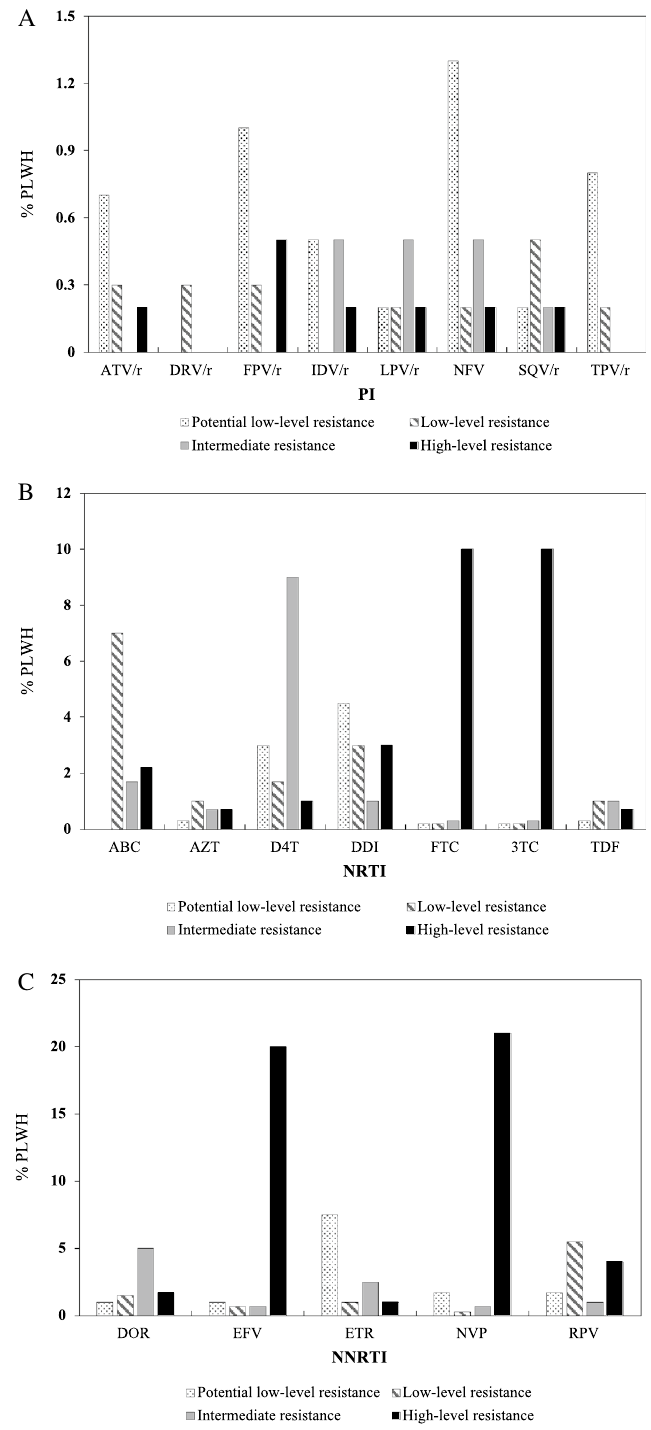
Figure 1. Antiretroviral drug resistance: ( A ) PI. r ritonavir-boosted, ATV atazanavir, DRV darunavir, FPV fosamprenavir, IDV indinavir, LPV lopinavir, NFV nelfinavir, SQV saquinavir, TPV tipranavir. ( B ) NRTI. ABC abacavir, ZDV zidovudine, D4T stavudine, DDI didanosine, FTC emtricitabine, 3TC lamivudine, TDF tenofovir disoproxil fumarate. ( C ) NNRTI. DOR doravirine, EFV efavirenz, ETR etravirine, NVP nevirapine, RPV